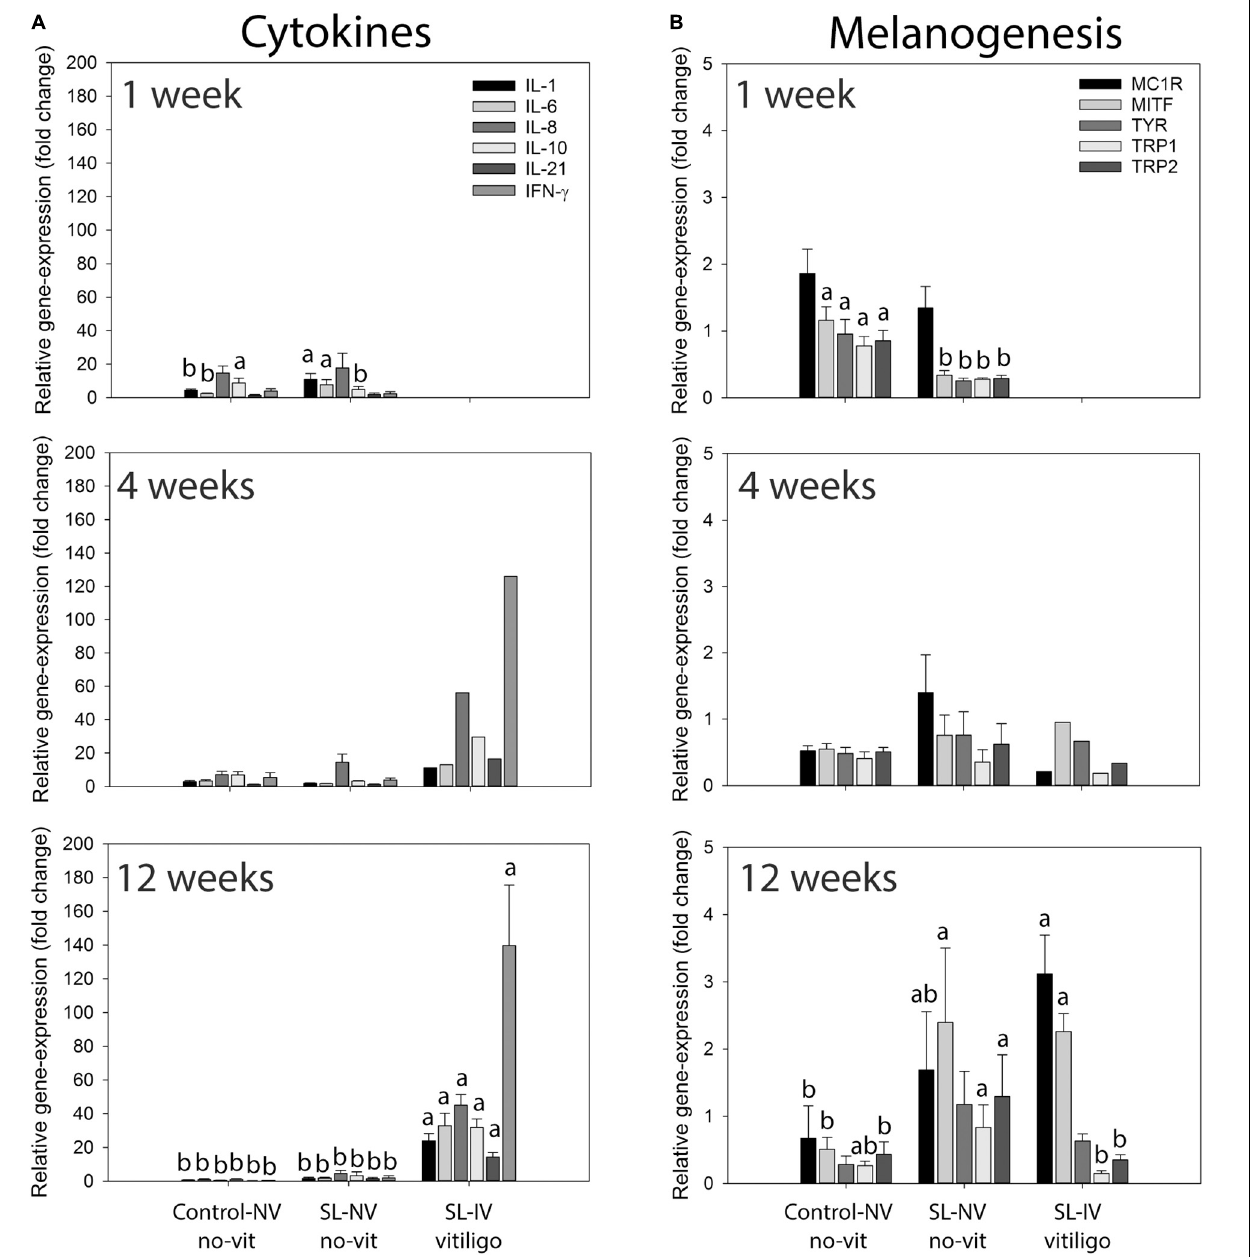
FIGURE 2 | Expression of cytokine and melanogenesis-related genes in eye tissue from healthy controls and Smyth line (SL) chickens with and without vitiligo and visual impairment. (A) Relative mRNA levels of interleukin-1 (IL-1), IL-6, IL-8 (CXCL8), IL-10, IL-21, and interferon- γ (IFN- γ ); (B) relative mRNA levels of melanocortin 1-receptor (MC1R), melanocyte-inducing transcription factor (MITF), tyrosinase (TYR), tyrosinase-related protein-1 (TRP1), and TRP2 (dopachrome tautomerase) in eyes from 1-, 4-, and 12-week-old controls, SL with normal (NV) and impaired vision (SL-IV; partial vision and blind). Relative mRNA expression of cytokines and melanogenesis-related genes in collected eyes was determined using qPCR. Data are mean ± SEM; for each age-group, n = 6 and 3 for control-NV and SL-NV, respectively; SL-IV: n = 0 at 1 week, n = 1 at 4 weeks, and n = 10 at 12 weeks. (A,B) Within an age group and across sample categories (control-NV, SL-NV, and SL-IV), mean mRNA expression levels of individual target genes without a common letter are different ( P ≤